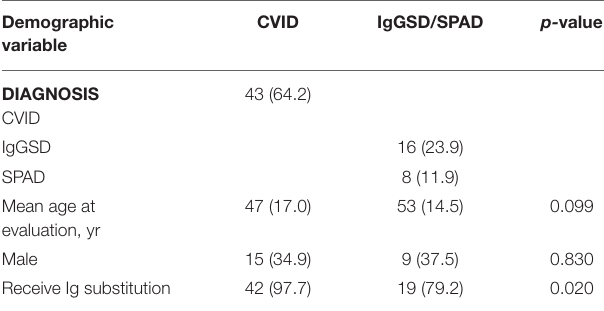
TABLE 2 | Baseline characteristics of included patient